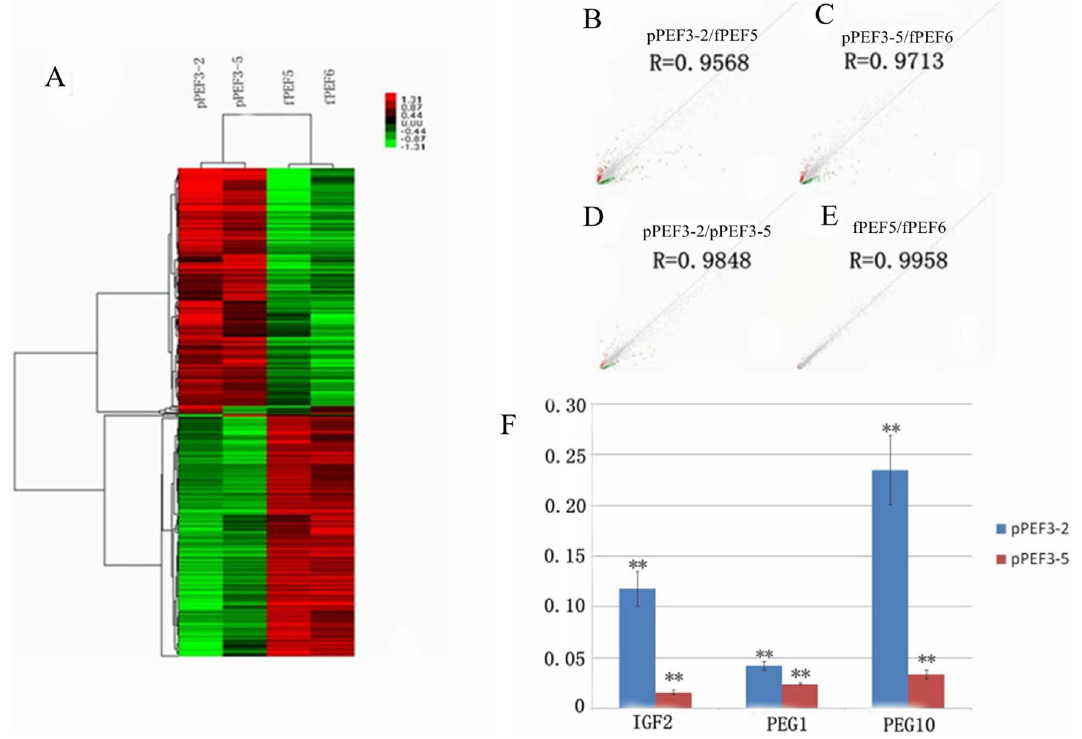
Figure 7. The microarray and RT-PCR analysis of PA embryo-derived fetal fibroblasts. (A) The heat map of PA embryo-derived fetal fibroblast cell lines and the corresponding female control cell lines. (B–E) The dot-blot comparison of different cell lines. (F) The real-time PCR results of imprinted genes. The fold change of three genes, the y-axis represents fold change.